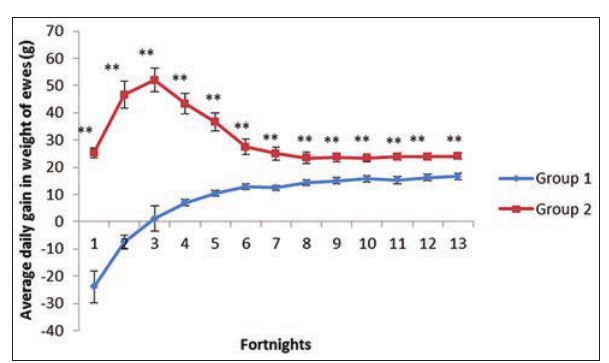
Figure-2: Mean±standard error values of fortnightly average daily gain in weight of ewes of different groups. *Significantly different from the base value (p<0.05). **Significantly different from the base value (p<0.01).